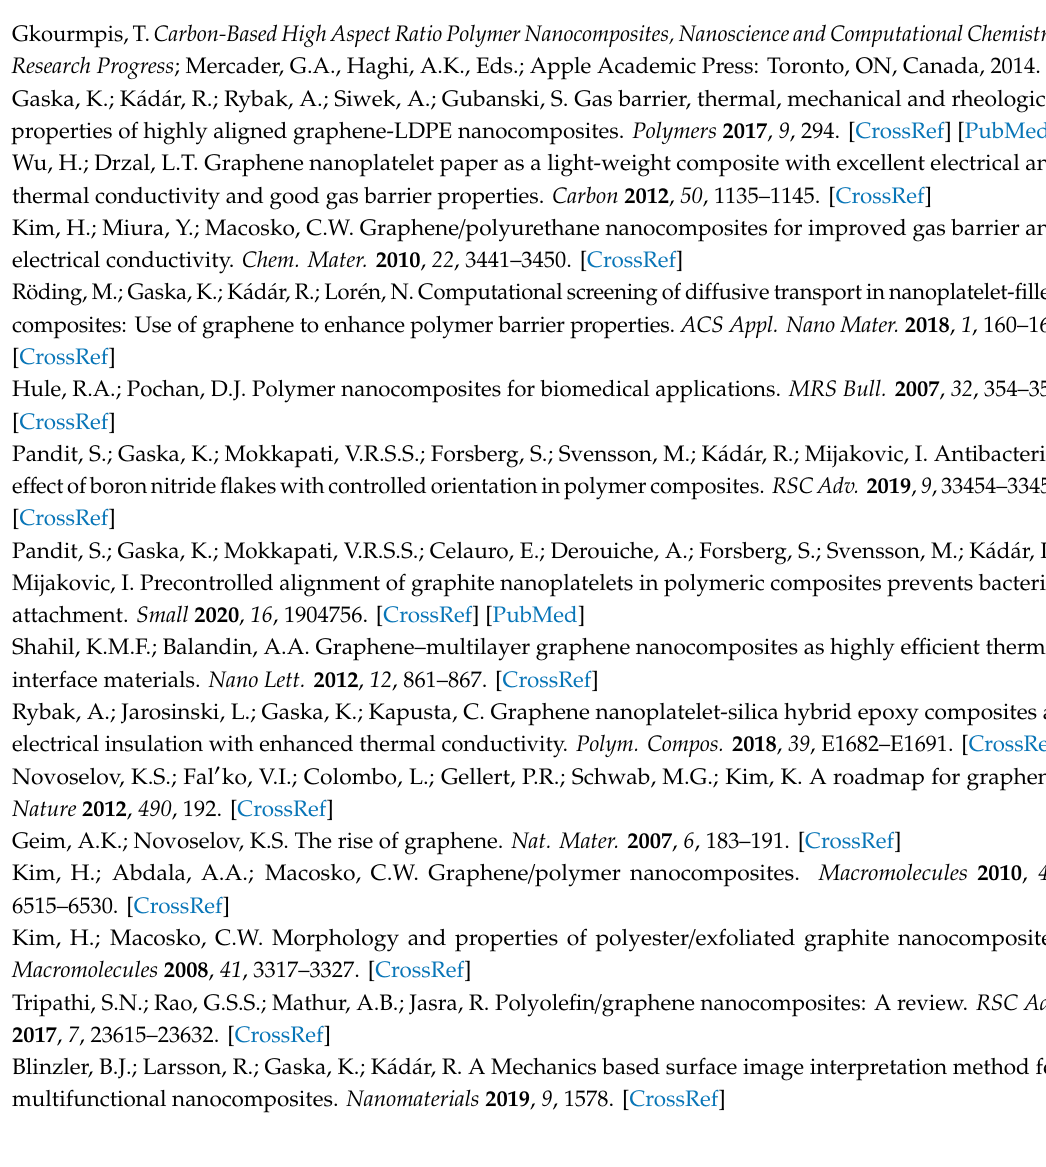
Supplementary information contains: Figure S1. Storage modulus at measured at di ff erent temperatures versus frequency for (a) iPP (b) 1.5 wt.% and (c) 4 wt.% samples. Table S1. Fit parameters of the Prony series. Table